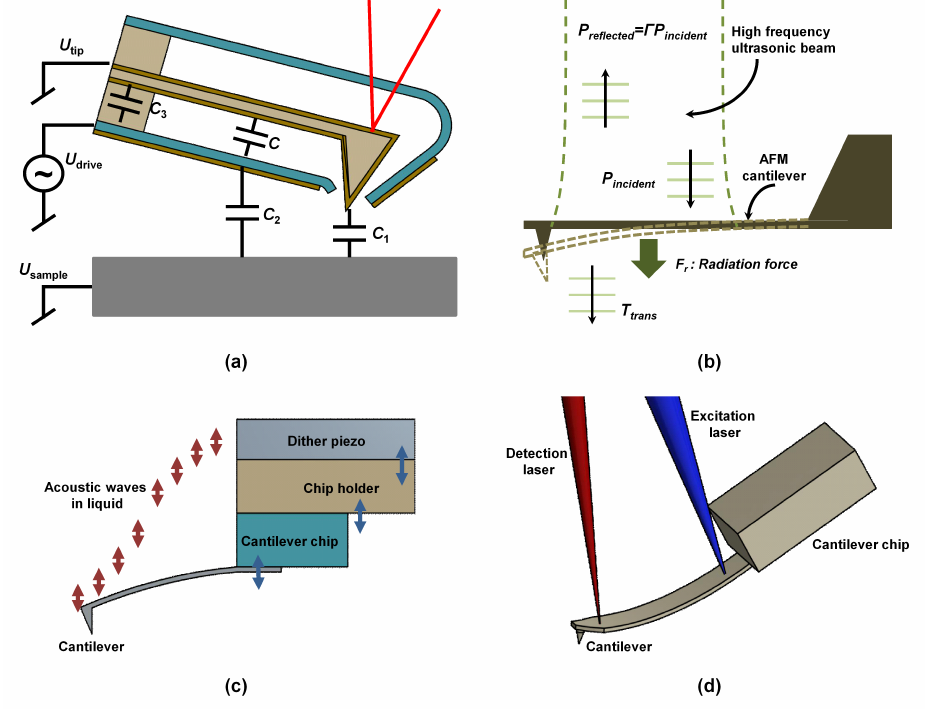
Figure 7. ( a ) A cross section showing the encased cantilever for electrostatic excitation. The capacitance C 1 , C 2 , and C 3 are parasitic capacitances whereas C is used for actuation [174], ( b ) acoustic radiation pressure excitation, ( c ) piezo-acoustic, and ( d ) photothermal excitation